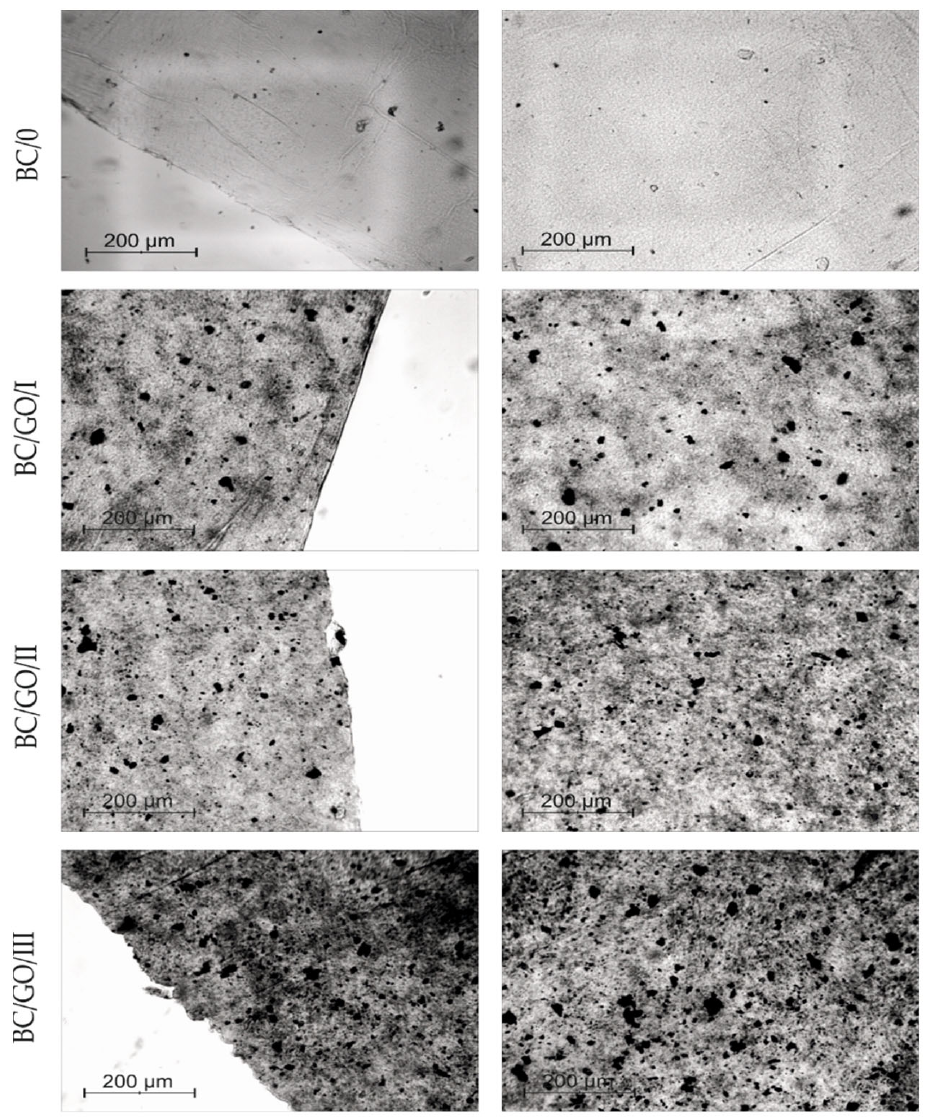
Figure 8. Optical microscope photos of BC (BC-0) samples and BC/GO/I, BC/GO/II, BC/GO/III composites.